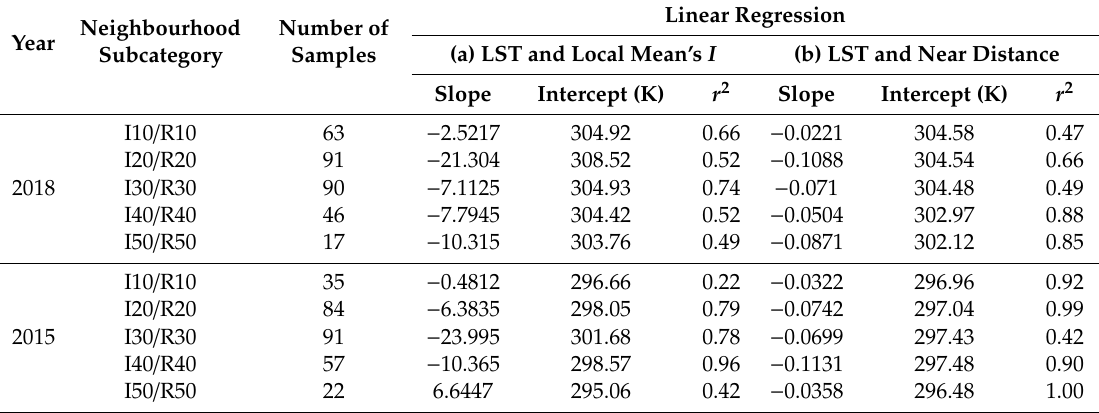
Table 9. Linear regression analysis between the mean LST values and mean values of (a) local Moran’s I , and (b) near distance for the neighbourhood subcategories.